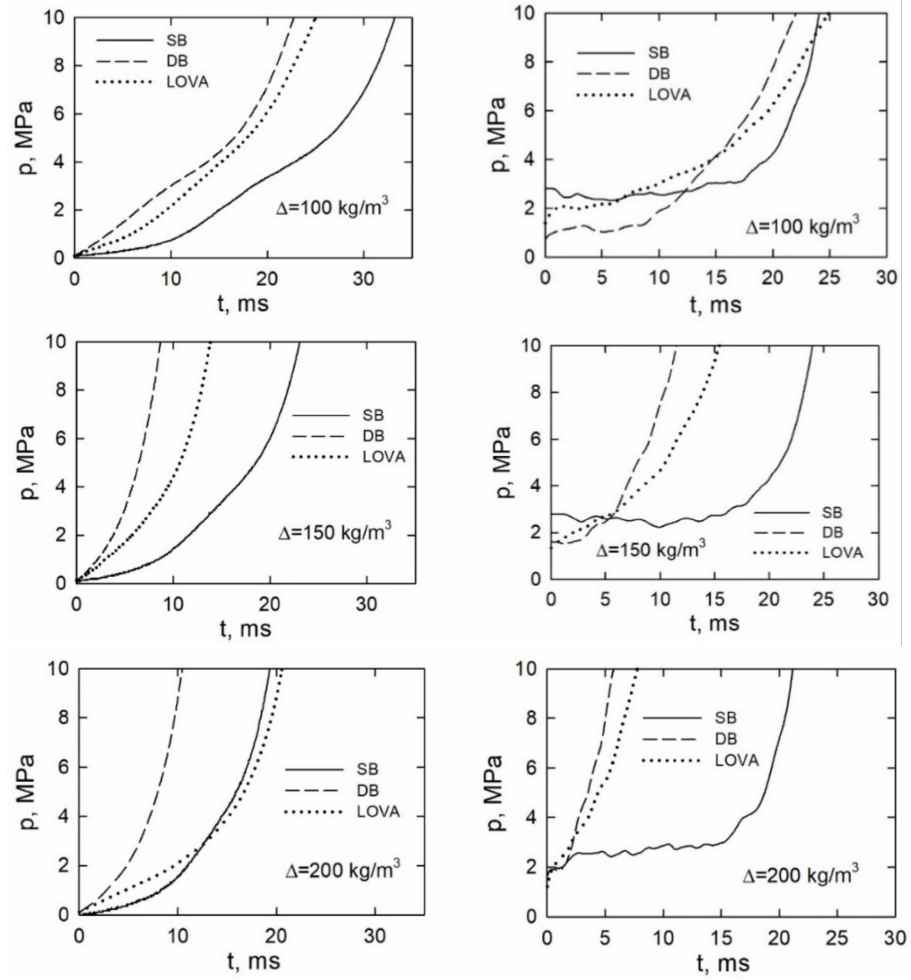
Figure 3. Initial parts of the pressure courses for gunpowder ignition ( left ) and plasma jet ignition ( right